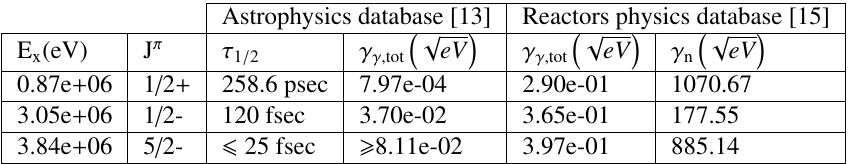
Table 1. Comparison between bound states parameters from the Astrophysics and the reactors physics databases as extracted from the unified